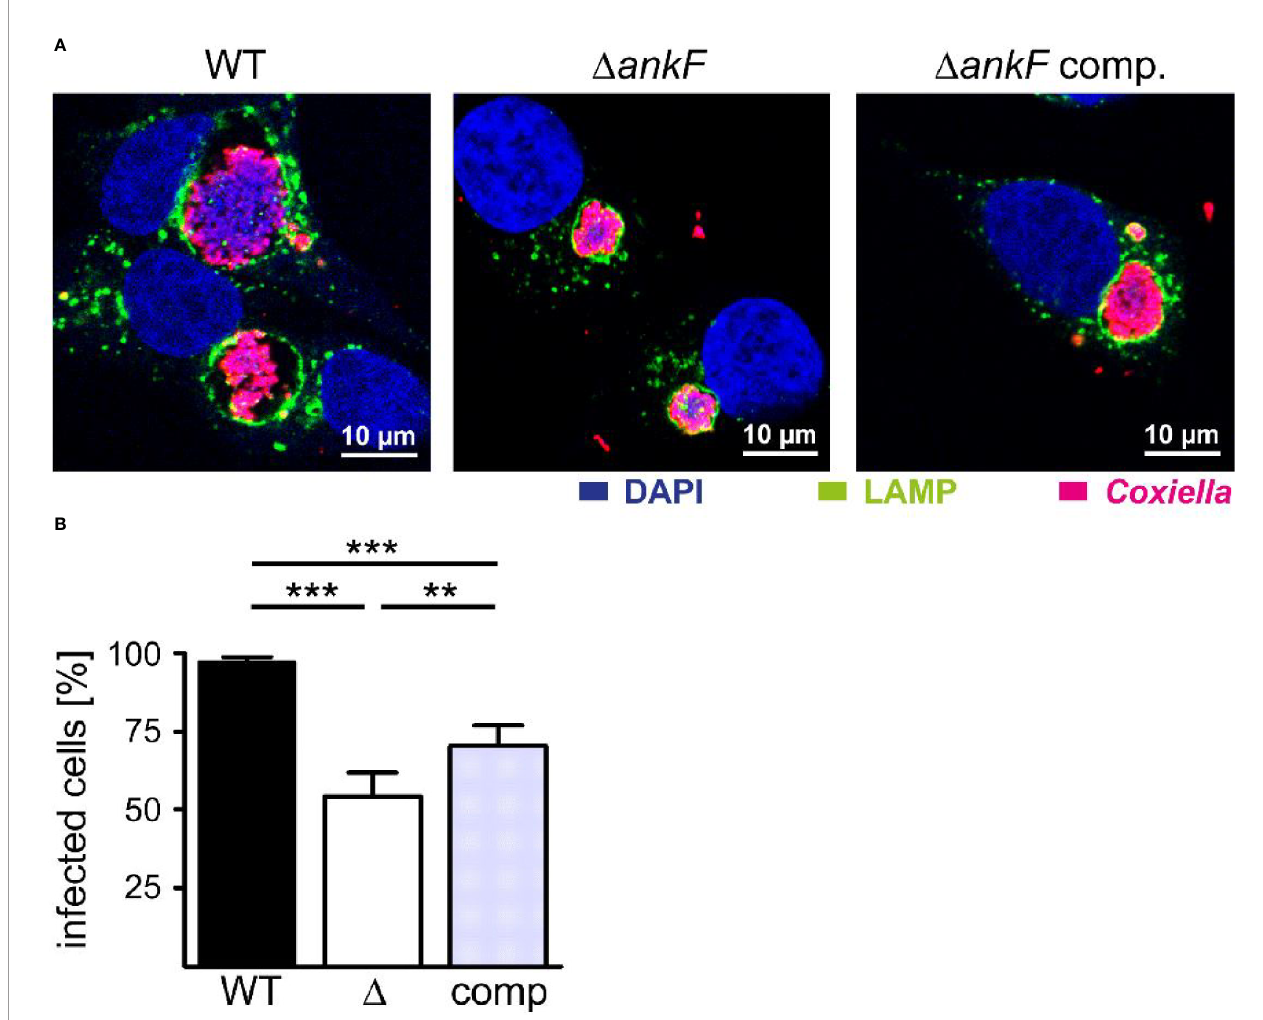
FIGURE 6 | The replication defect of D ankF C. burnetii can be complemented. HeLa cells were infected with C. burnetii wild-type (WT), D ankF or D ankF ::AnkF at an MOI of 100. At 60 h post-infection, the cells were fi xed and stained with an anti-LAMP2 antibody (green) and with antisera against C. burnetii (red). Nuclei and bacterial DNA were stained with DAPI (blue). (A) Representative LSM images of three independent experiments are shown. (B) The percentage of infected cells were determined by analyzing 100 cells per experiment in three independent experiments. Error bars indicate ± SD. ** p < 0.01, *** p <